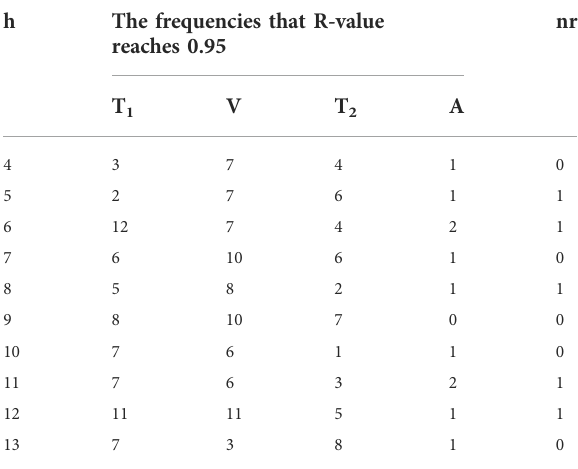
TABLE 4 The frequencies that R-value reaches 0.95 (performing on the training group of matrix 2). h The frequencies that R-value reaches 0.95